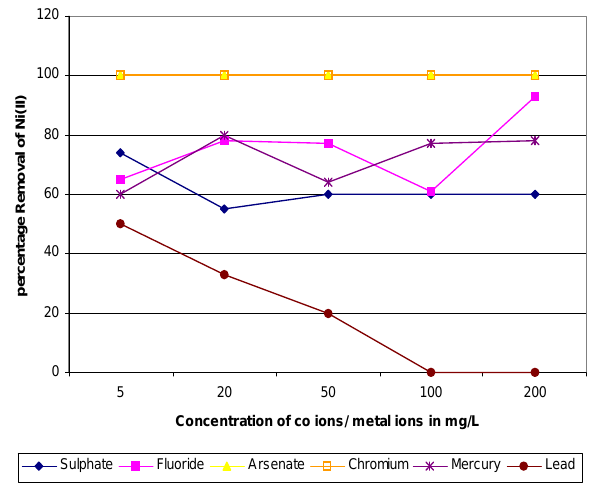
Figure 6: Effect of common ions on the biosorption of Ni(II) with chemically leached biomass at pH 3 Column Study